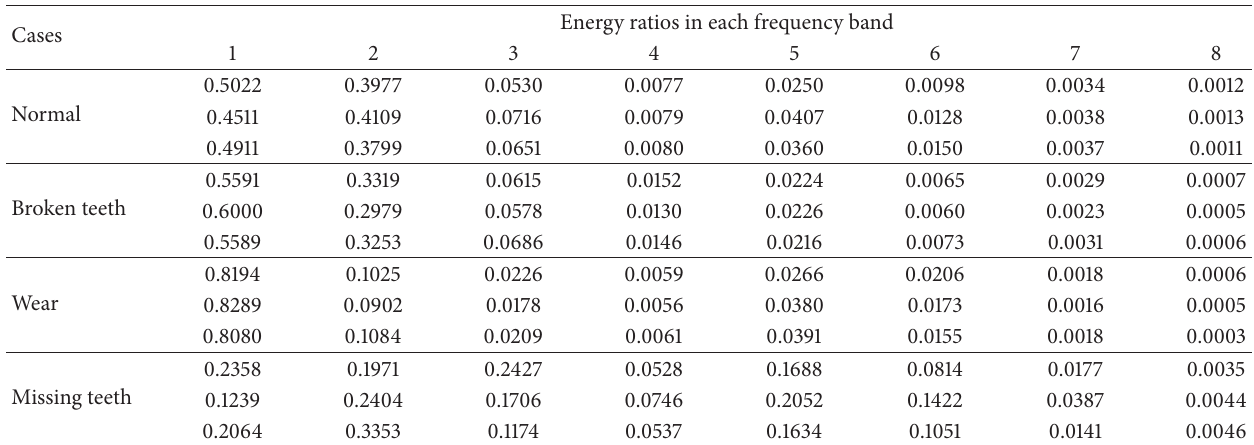
Table 4: Gear training samples.